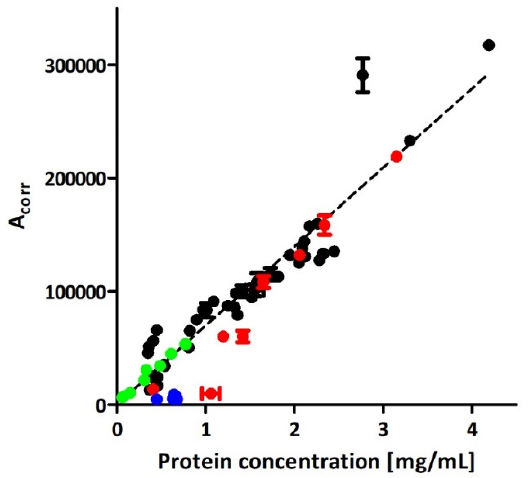
Figure 2. Comparison of EVs quantitation with CE and BCA in isolates obtained with direct UC (blue trace), ICUC (black and red traces), and IDGUC (green trace) methods. The red trace represents isolates that, based on the CE analysis, were considered impure (comment in Section 3). The linear curve was plotted based on the quantitative data obtained for 42 independent isolates, achieved with the ICUC method (black trace). Error bars represent the SD of two measurements.